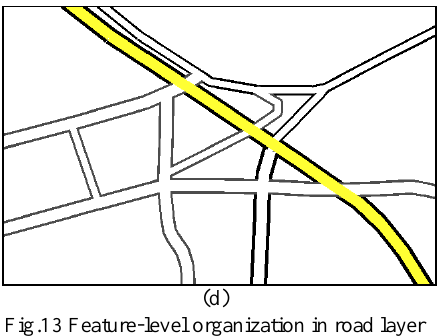
Fig.13 Feature-level organization in road layer